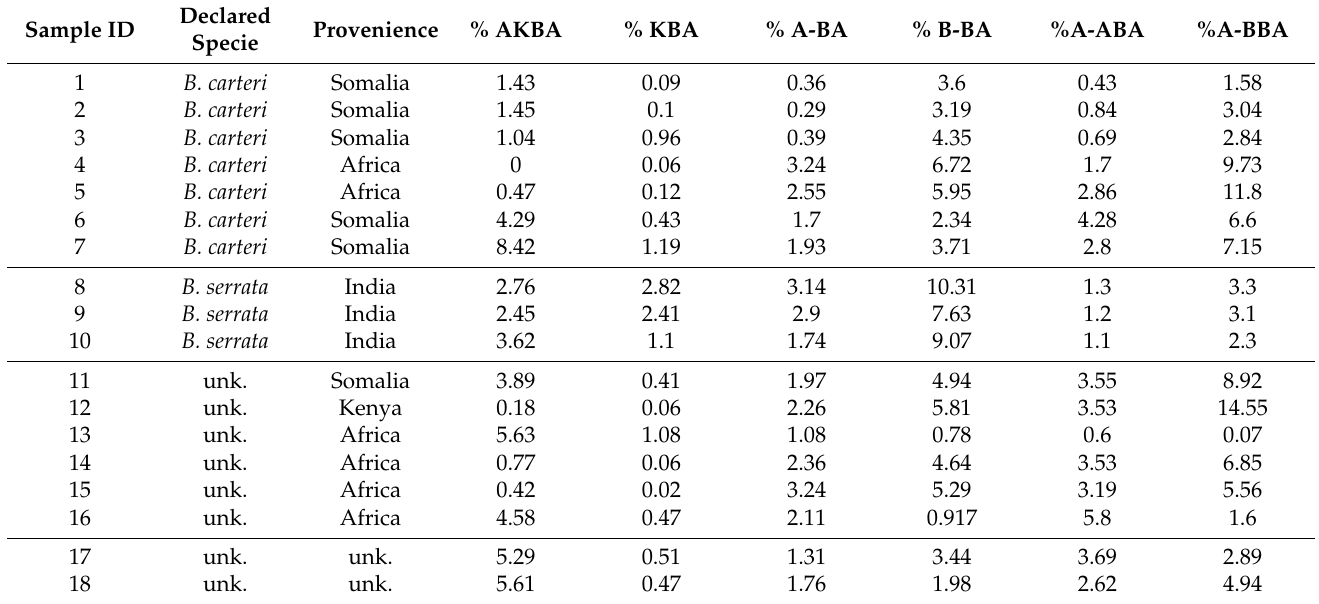
Table 2. Table listing all the samples analyzed in the study with the validated method. Each row reports the sample ID on the first column; declared species reports, for each sample, its species, with “unk” if unknown; provenience reports the national or territorial origin of the sample, with “unk” if unknown. The remaining column reports the concentrations of each boswellic acid studied expressed as weight percentage or g/100 g, and all the observations are an average value of 2 or more analytical repetitions with an RSD value lower than